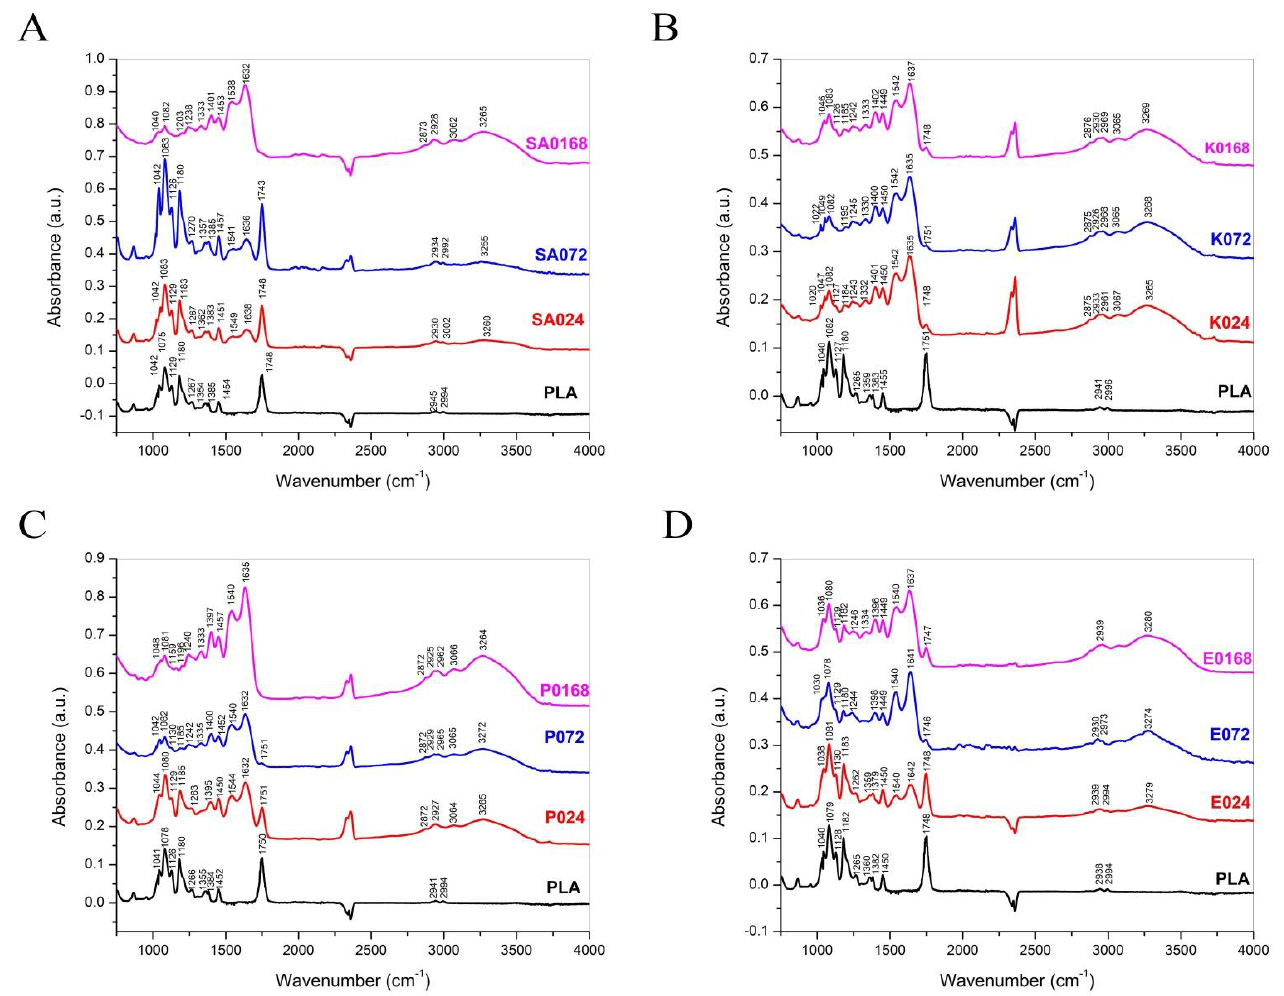
Figure 8. Fourier Transform Infrared (FTIR) Spectroscopy images of biofilm cultivated for 24 h, 72 h and 168 h on the PLA surface. ( A ) = Staphylococcus aureus (SA) biofilm at 24 h (SA024), 72 h (SA072) and 168 h (SA0168). ( B ) = Klebsiella pneumoniae (K) biofilm at 24 h (K024), 72 h (K72) and 168 h